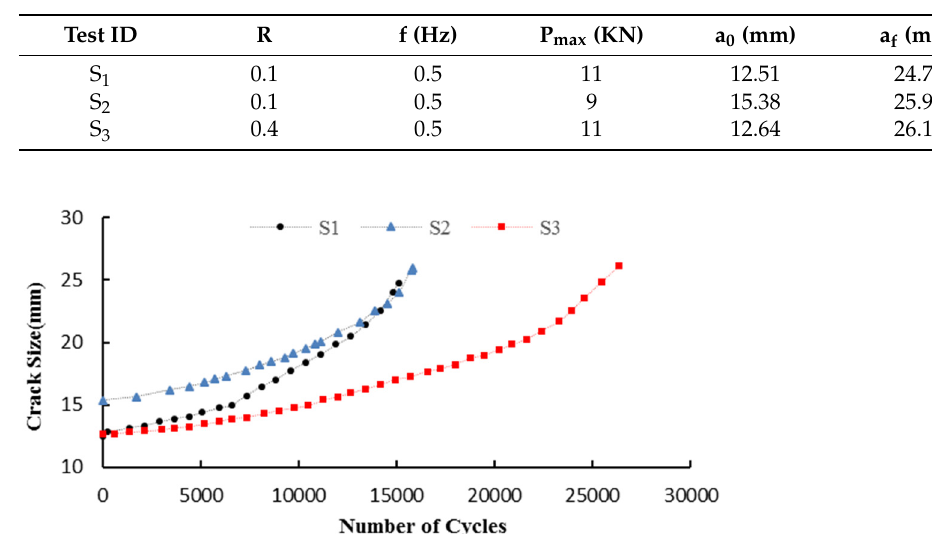
Table 1. Parameters and results of fatigue crack growth test. Data adopted from [5].